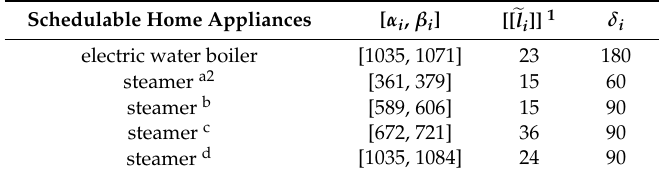
Table 3. Statistically identified physical characteristics [15] of the enrolled schedulable home